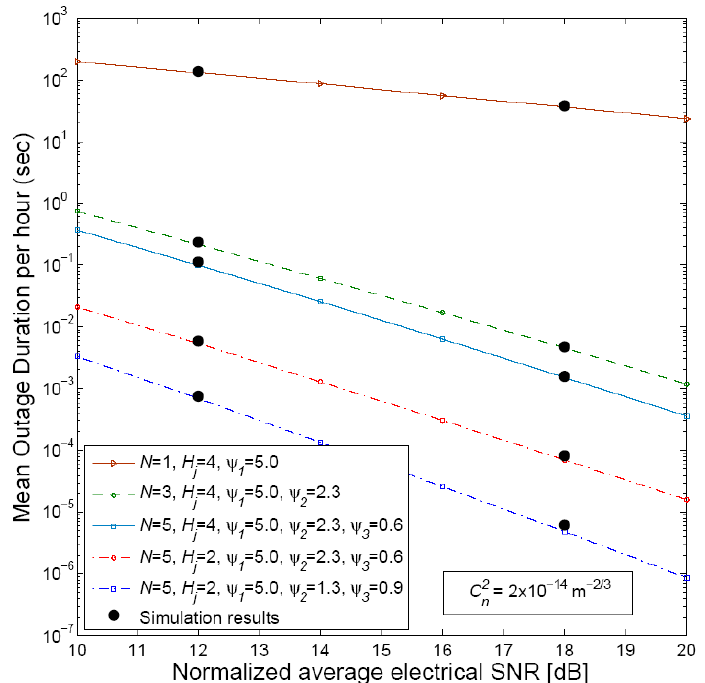
Figure 7. Total mean outage duration time (MOD) of a relay-aided system with both varying path and hop configurations as a function of a wide range of γ / µ , for gamma-gamma (G-G) modeled weak turbulent channels along with different amounts of pointing mismatch.